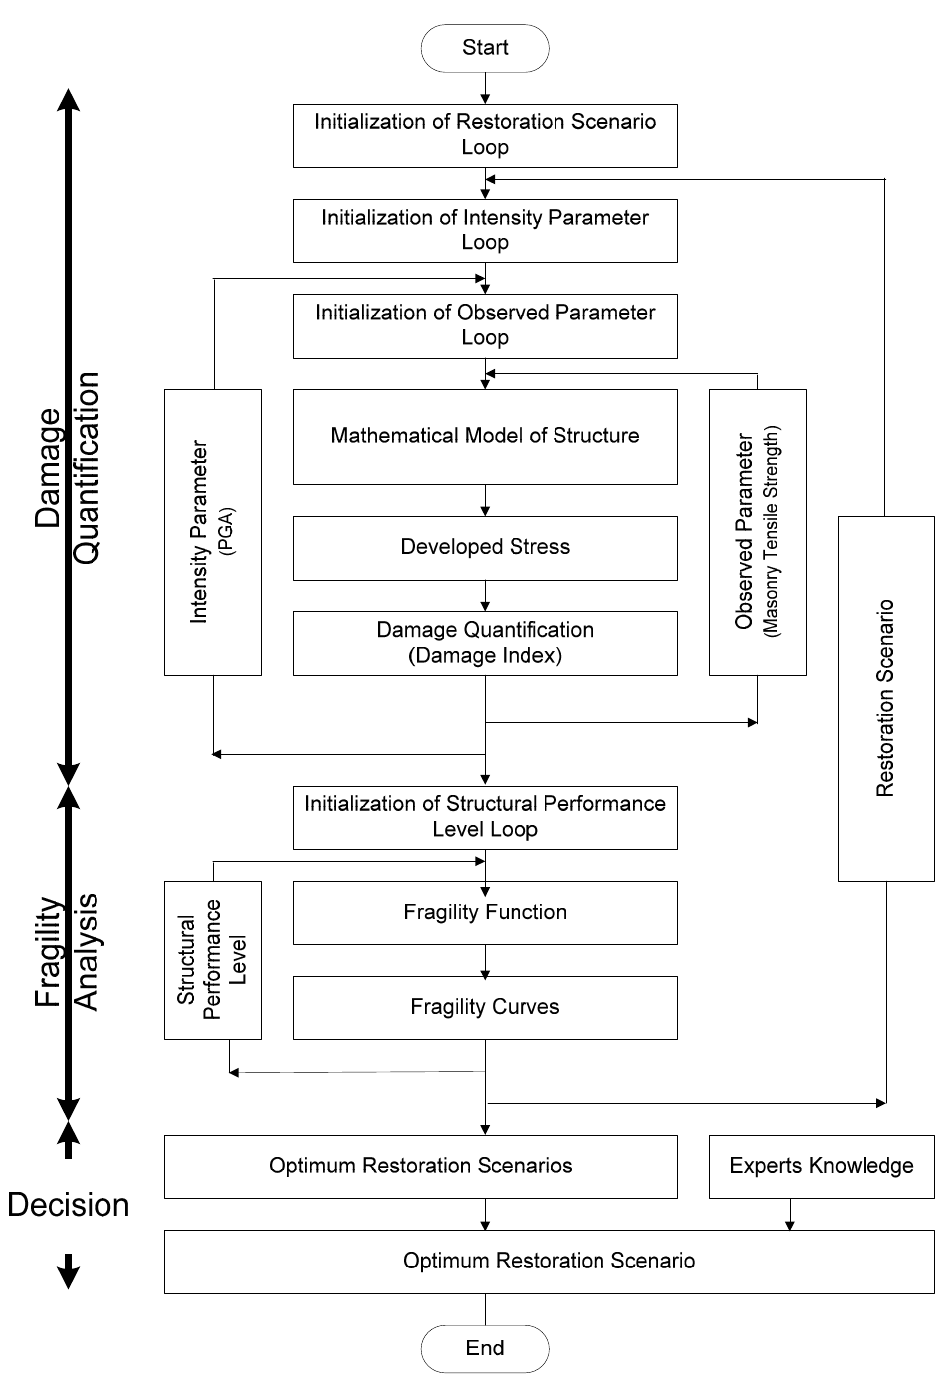
Figure 1. Flowchart depicting the applied methodology for vulnerability and restoration assessment. PGA, peak ground acceleration.